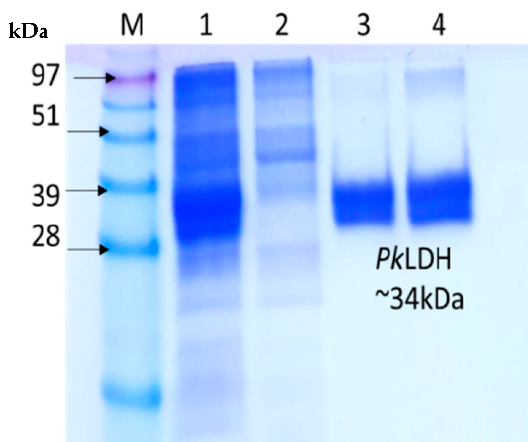
Figure 4. The purified protein exhibited a single band at 34 kDa based on 12% SDS-PAGE analysis. kDa: Protein Ladder, Lane 1: Crude Protein, Lane 2: Unbound Protein after IMAC, Lane 3: Eluted Protein after IMAC, and Lane 4: Eluted Protein after size exclusion chromatography.